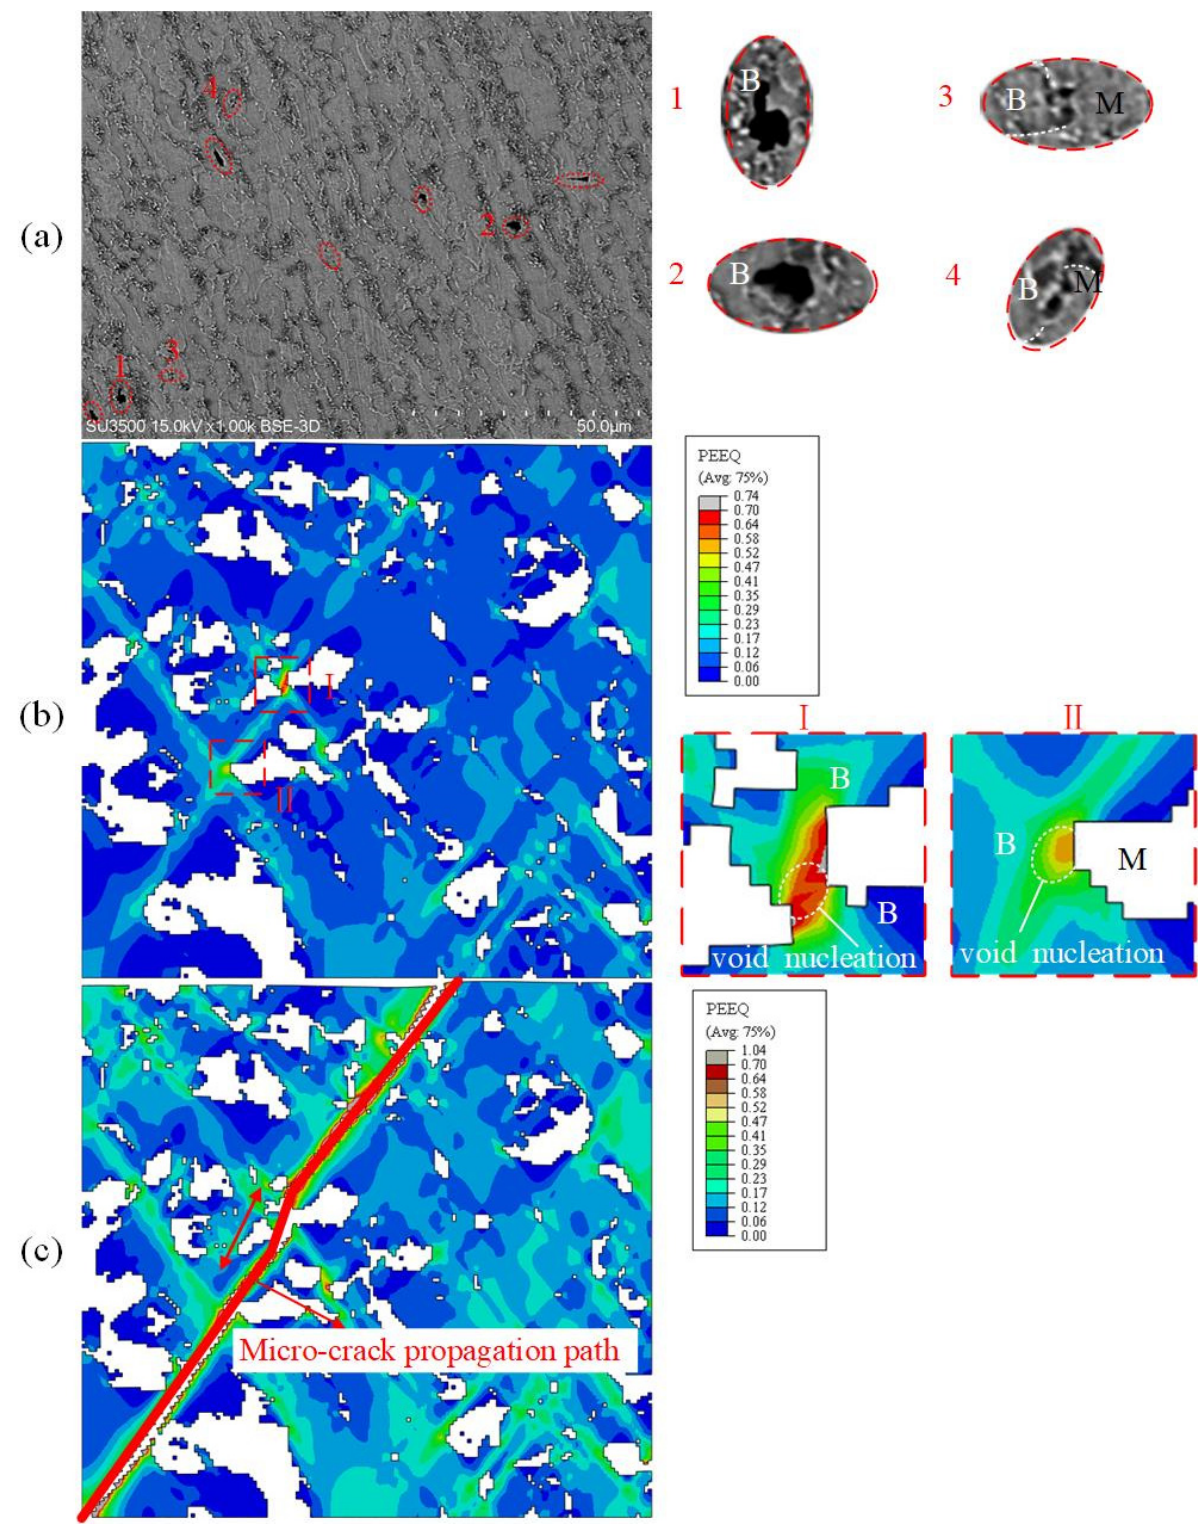
Figure 24. Comparison between SEM and simulation of 80%B + 20%M uniaxial tensile specimens: ( a ) SEM micrographs of damage mechanisms; ( b ) PEEQ during void nucleation; ( c ) PEEQ at complete fracture.